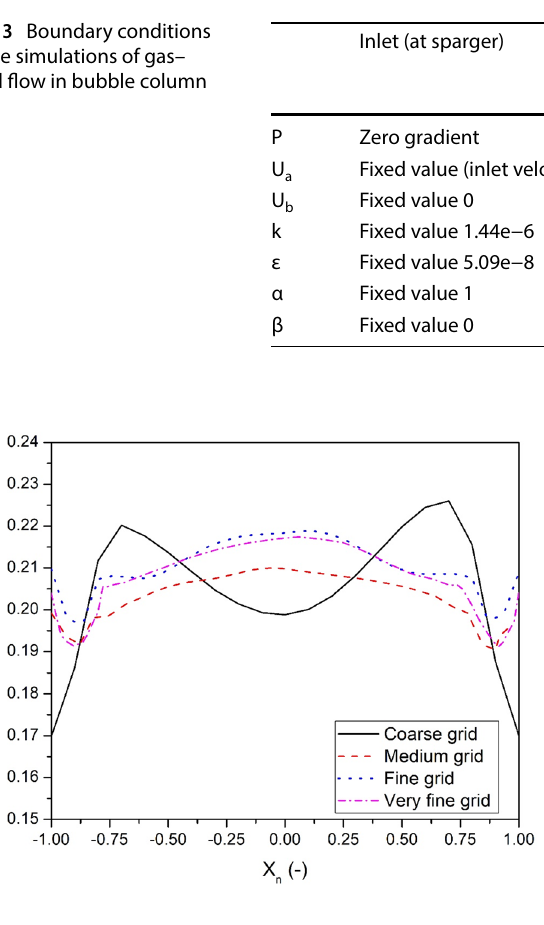
Fig. 3 Effects of grid resolution on time-averaged gas phase frac- tions using A1 (100%) sparger and gas velocity of 5.8